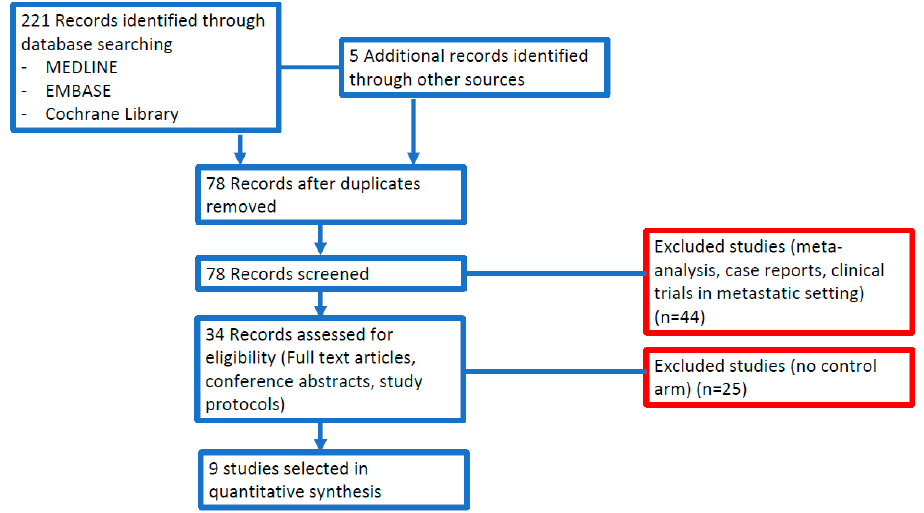
Figure 1. Study flow diagram.